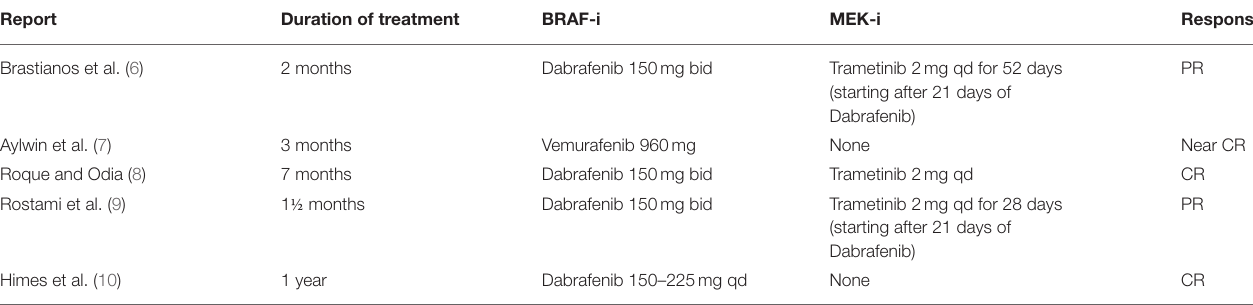
TABLE 2 | Published case reports of brain tumors treated with